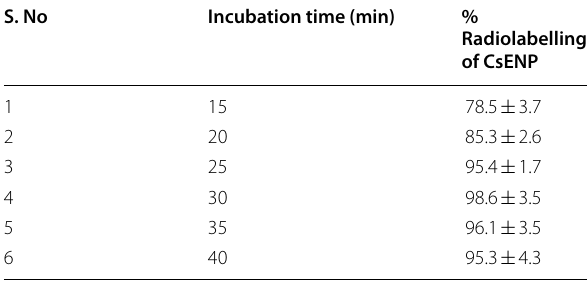
The values represent mean